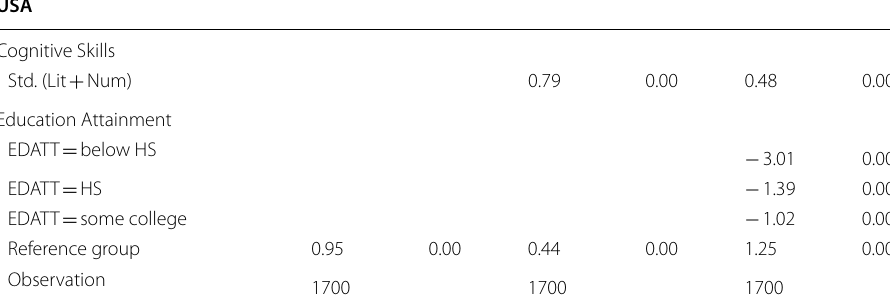
Table 8 D-statistics for goodness of fit: Q1 analyses